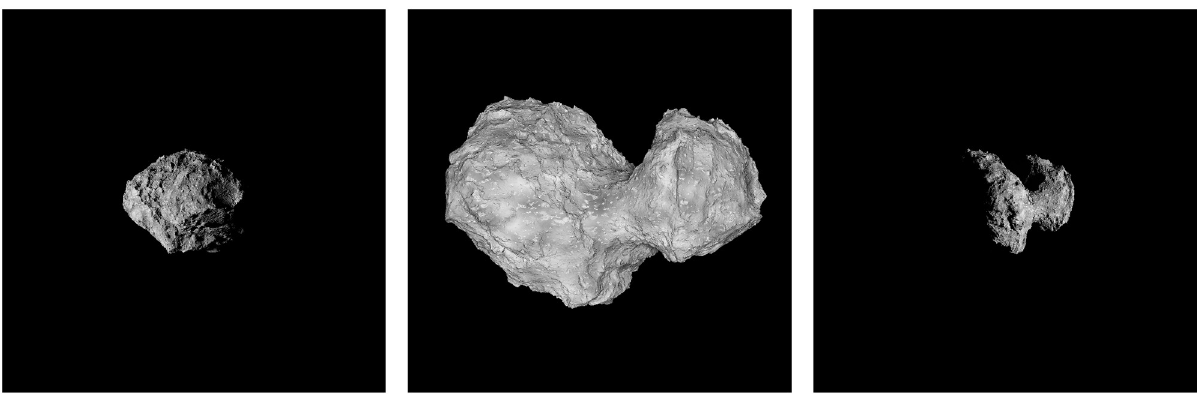
Fig 13. Three out of 25 frames used for the reconstruction. Images rendered in SISPO. Furthest approaching frame, closest approach and furthest leaving frame.